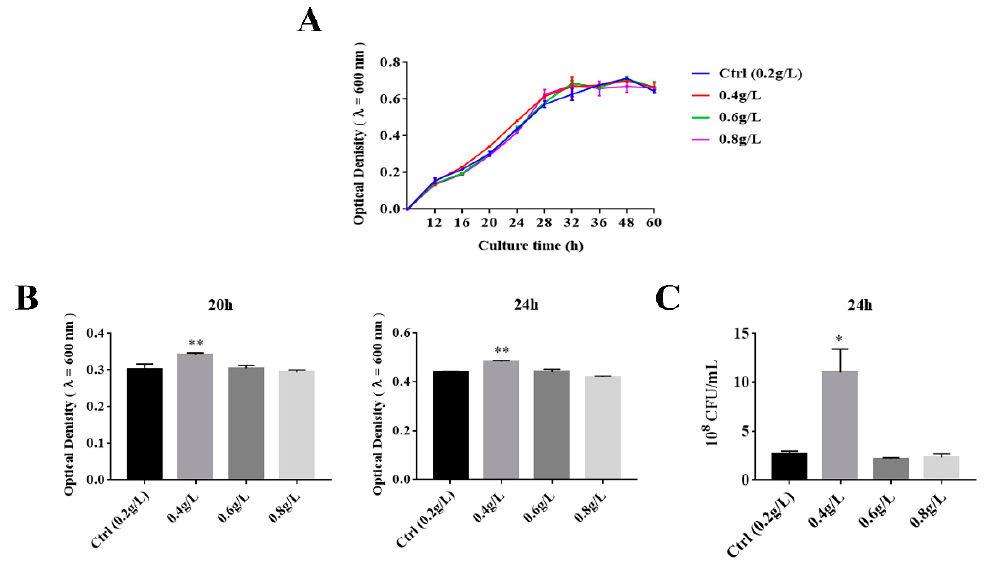
Figure 1. Effects of 0.2, 0.4, 0.6, and 0.8 g/L of tryptophan on growth of A. muciniphila BAA-835T. ( A ) The growth curve of A. muciniphila BAA-835T grew with different concentrations of tryptophan. ( B ) Optical density of A. muciniphila BAA-835T at 20 and 24 h. ( C ) CFU/mL of A. muciniphila BAA-835T at 24 h. One-way ANOVA with a post hoc Dunnett test was used to determine statistical differences, compared with the Ctrl group. * p < 0.05, ** p < 0.01.